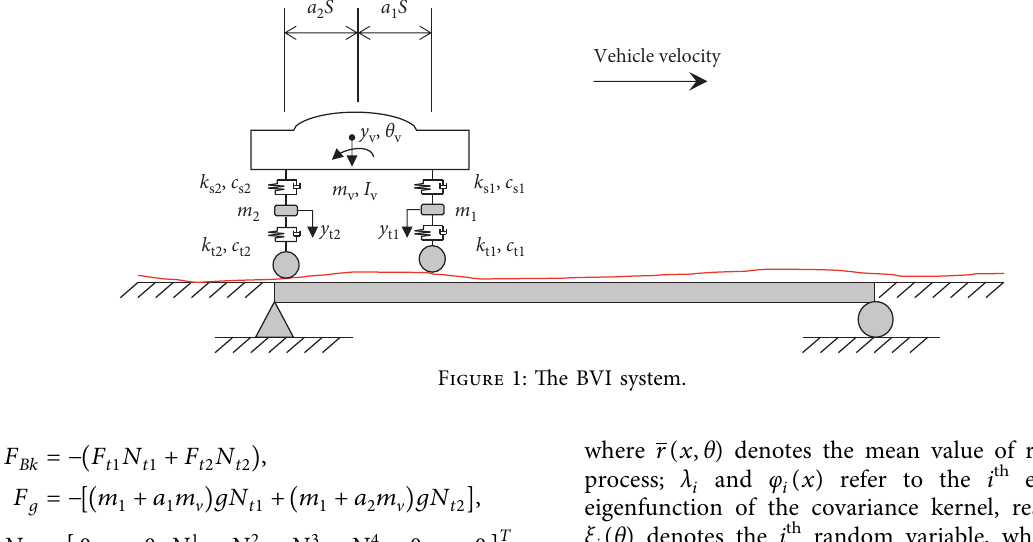
Figure 1: The BVI